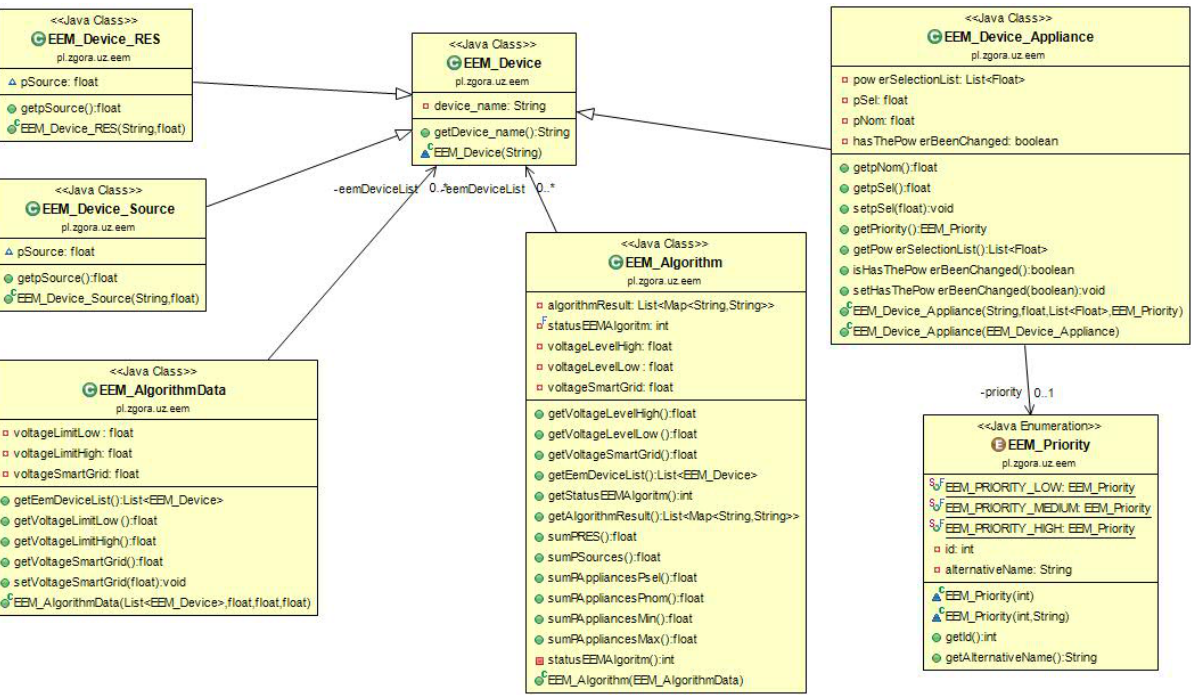
Figure 7. Class diagram for the implemented EEM